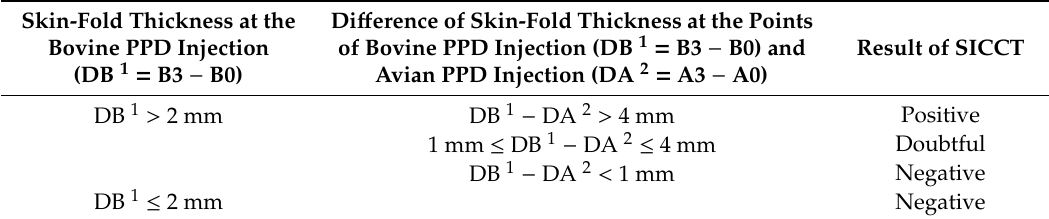
Table 1. Interpretation of the results of the single intradermal cervical comparative test (SICCT). Skin-Fold Thickness at the Bovine PPD